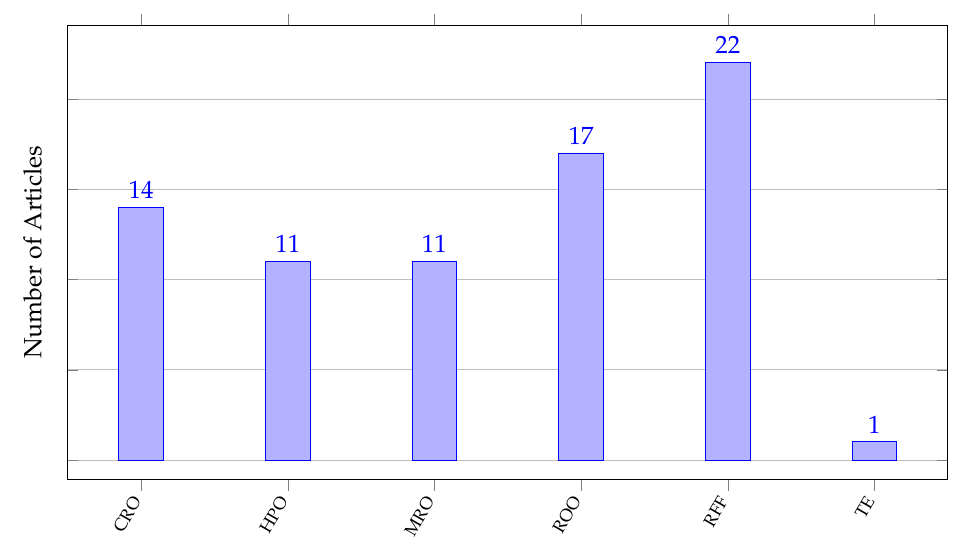
Figure 6. Main purpose of each work. Figure 7 represents the combination of ML groups with the article’s primary purpose.